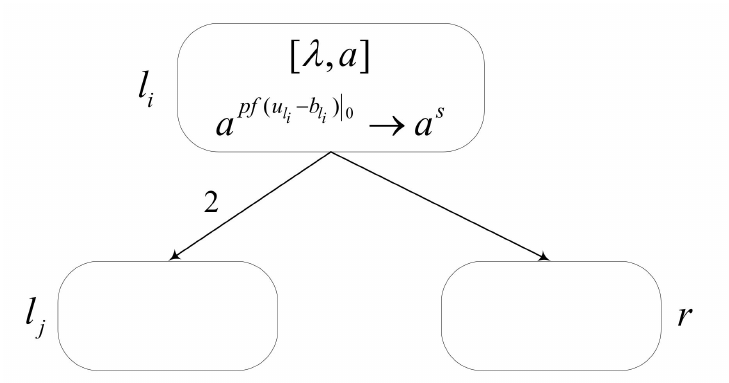
Figure 9. Module ADD’. Its function is to simulate deterministic ADD instruction l i : ( ADD ( r ) , l j )